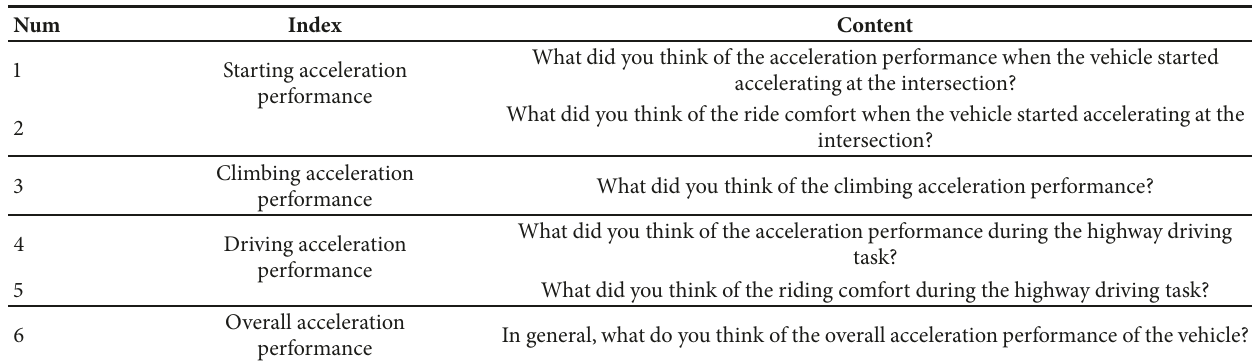
Table 1: Subjective evaluation items for acceleration